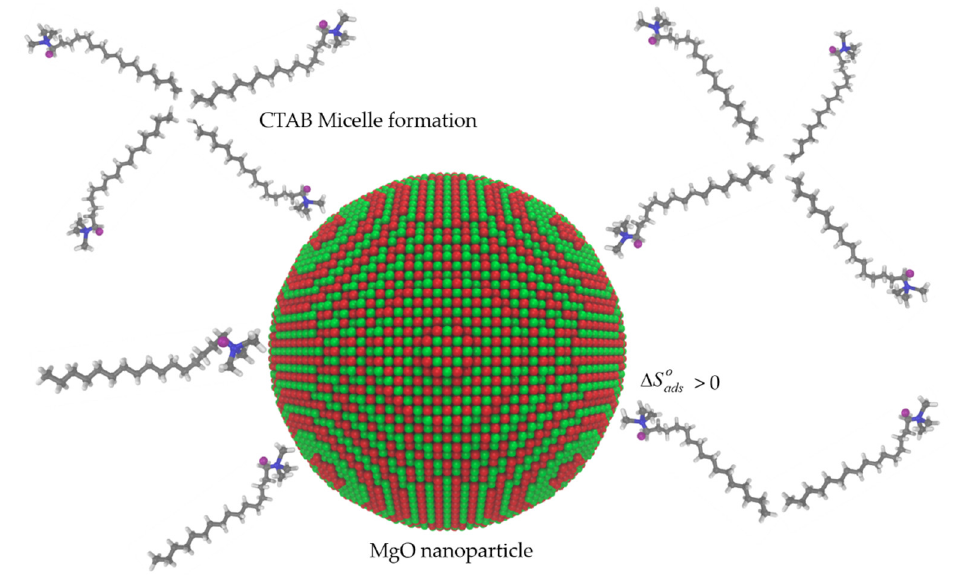
Figure 7. Conceptual scheme of the interaction between the MgO nanoparticles and CTAB surfactant molecules for the nanocomposites studied in System II based on the energy minimization for each of the components using molecular dynamics. Magnesium is shown in green, oxygen in red, carbon in grey, hydrogen in white, and bromium in purple.